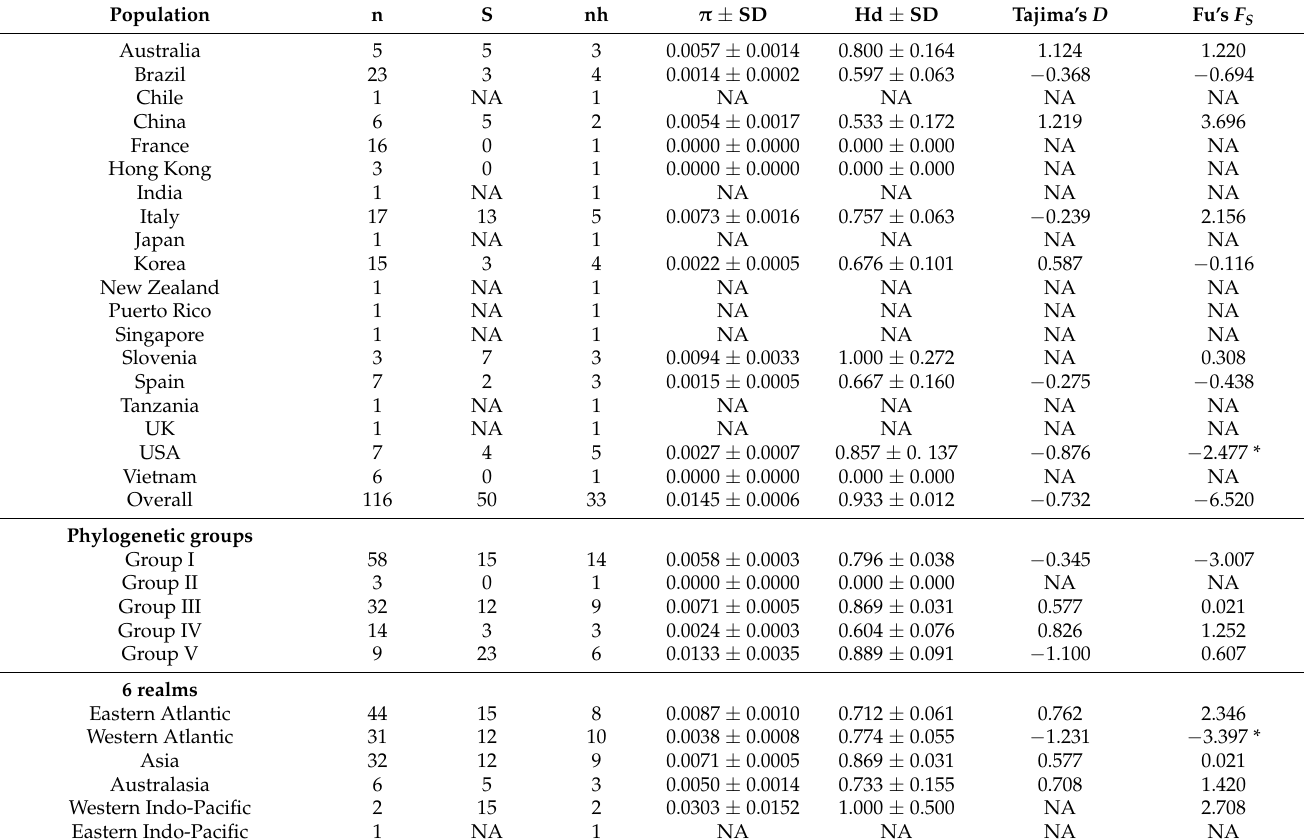
Table 1. Information of sample sizes and genetic characteristics of 19 populations, five phylogroups, and six realms of Gelidium crianle based on mitochondrial COI-5P